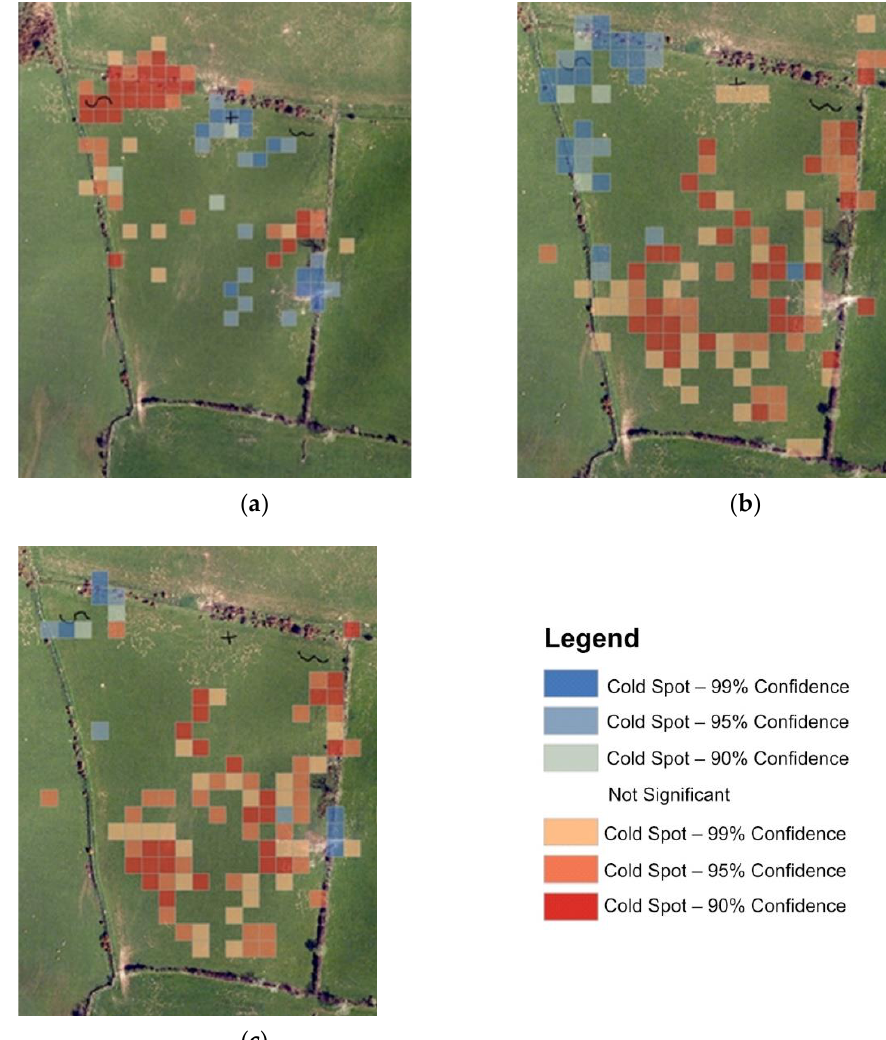
Figure 3. Getis-Ord Gi* Hotspot Analysis for ( a ) Wind speed ( b ) Wind-chill ( c ) Temperature, a hotspot (red) for wind speed indicates a clustering in sheep locations during high winds, with a coldspot for wind-chill and temperature indicating clustering according to low wind-chill and temperatures. For the associated weather conditions during the study period see Table 2, and for z scores see Table